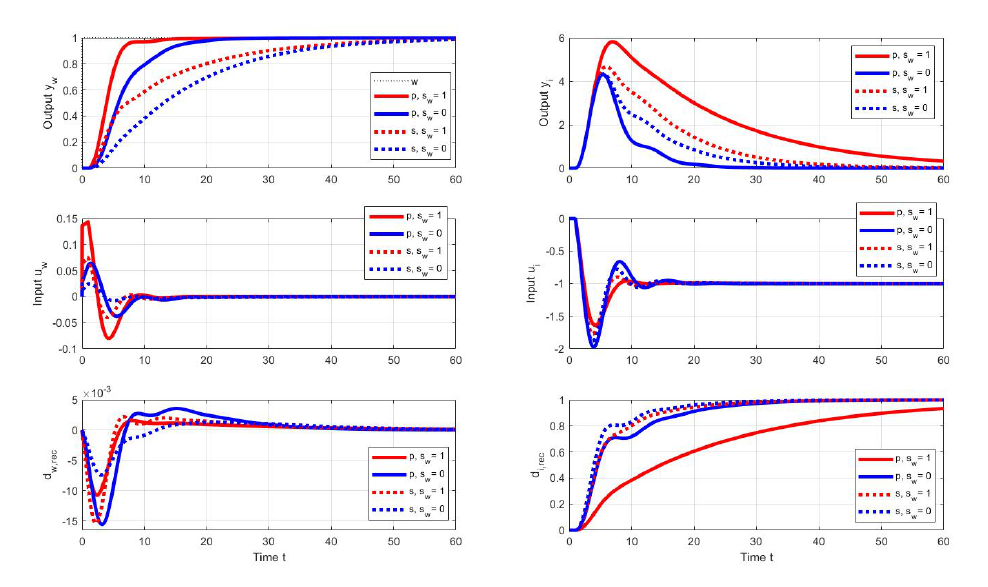
Figure 12. Unit setpoint step responses ( left ) and unit input disturbance step responses ( right ) achieved with the parallel (p) and series (s) PID controllers (black) with the optimal tuning calculated by the PPM over the parameter grid (41) under the output performance specifications (55) and (44) and the cost function weights s w = 1 and s w = 0, s i = 1 − s w ; T m = 1; K s = 1; T s =